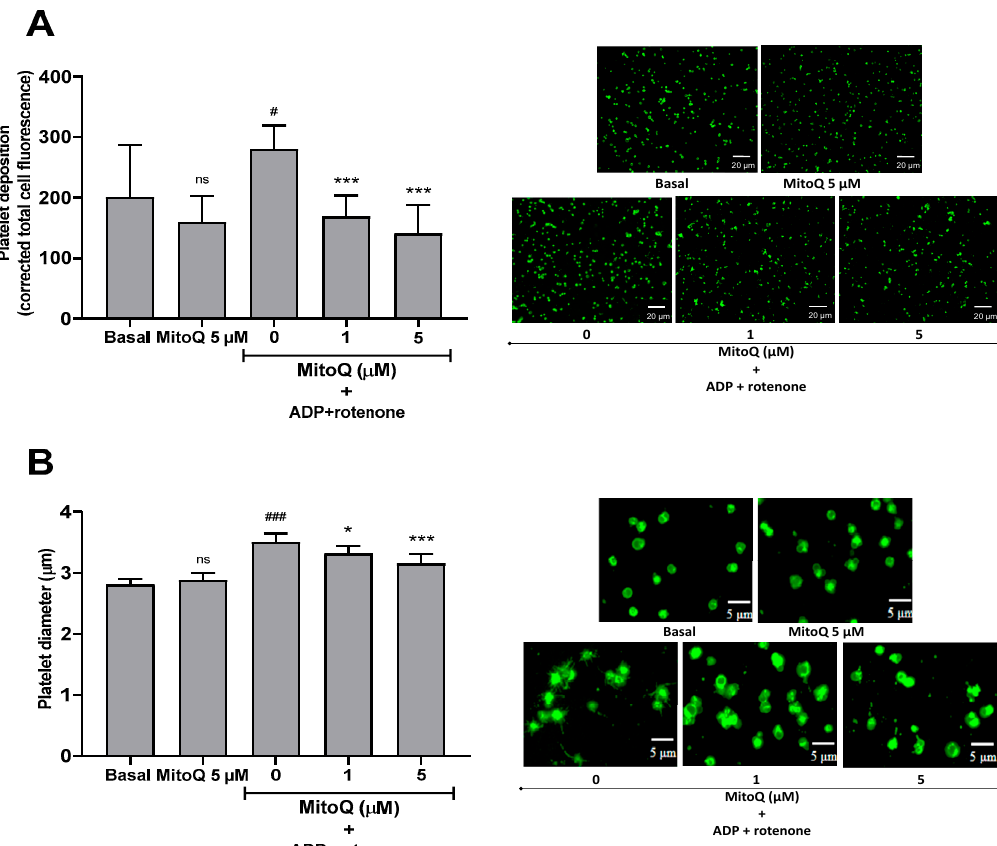
Figure 2. E ff ect of MitoQ on platelet deposition and spreading. E ff ect of MitoQ on platelet deposition ( A ) and spreading ( B ) on collagen-coated surfaces generated by mitochondrial dysfunction induced by rotenone plus ADP, and their representative images of each assay. The statistical analysis was performed using the ANOVA (Tukey test), ns: not significant, # p < 0.05 and ### p < 0.001 vs. basal, and * p < 0.05 and *** p < 0.001 vs. activated platelets (ADP plus